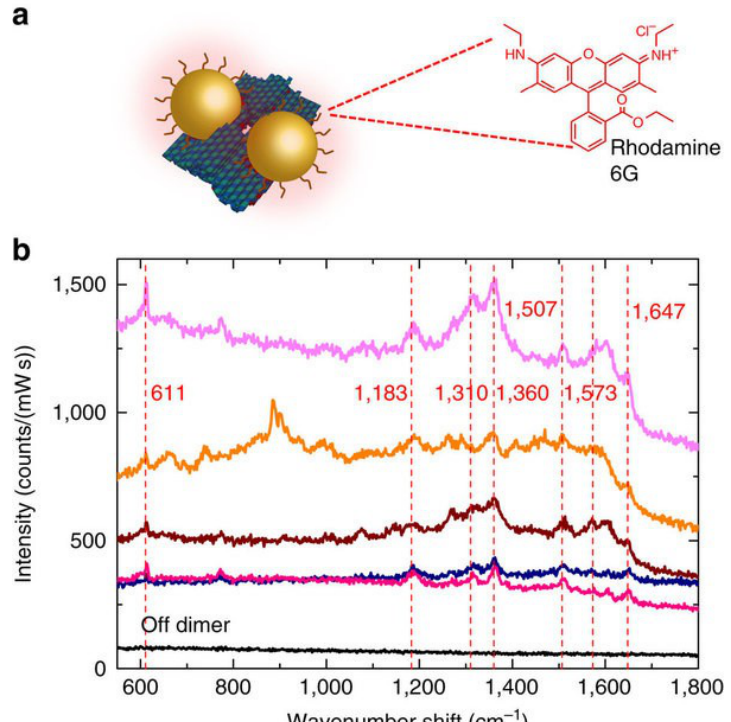
Figure 10. SERS measurements of an external analyte. ( a ) SEBS measurements of a thin layer of Rhodamine 6G adsorbed onto individual dimer structures plated on a gold-coated silicon wafer; ( b ) each spectrum peak is clearly visible (indicated by a dashed line). By contrast, a spectrum taken from a region away from the dimers (―off dimers‖) is of low intensity and does not display any peaks. Reprinted by permission from Macmillan